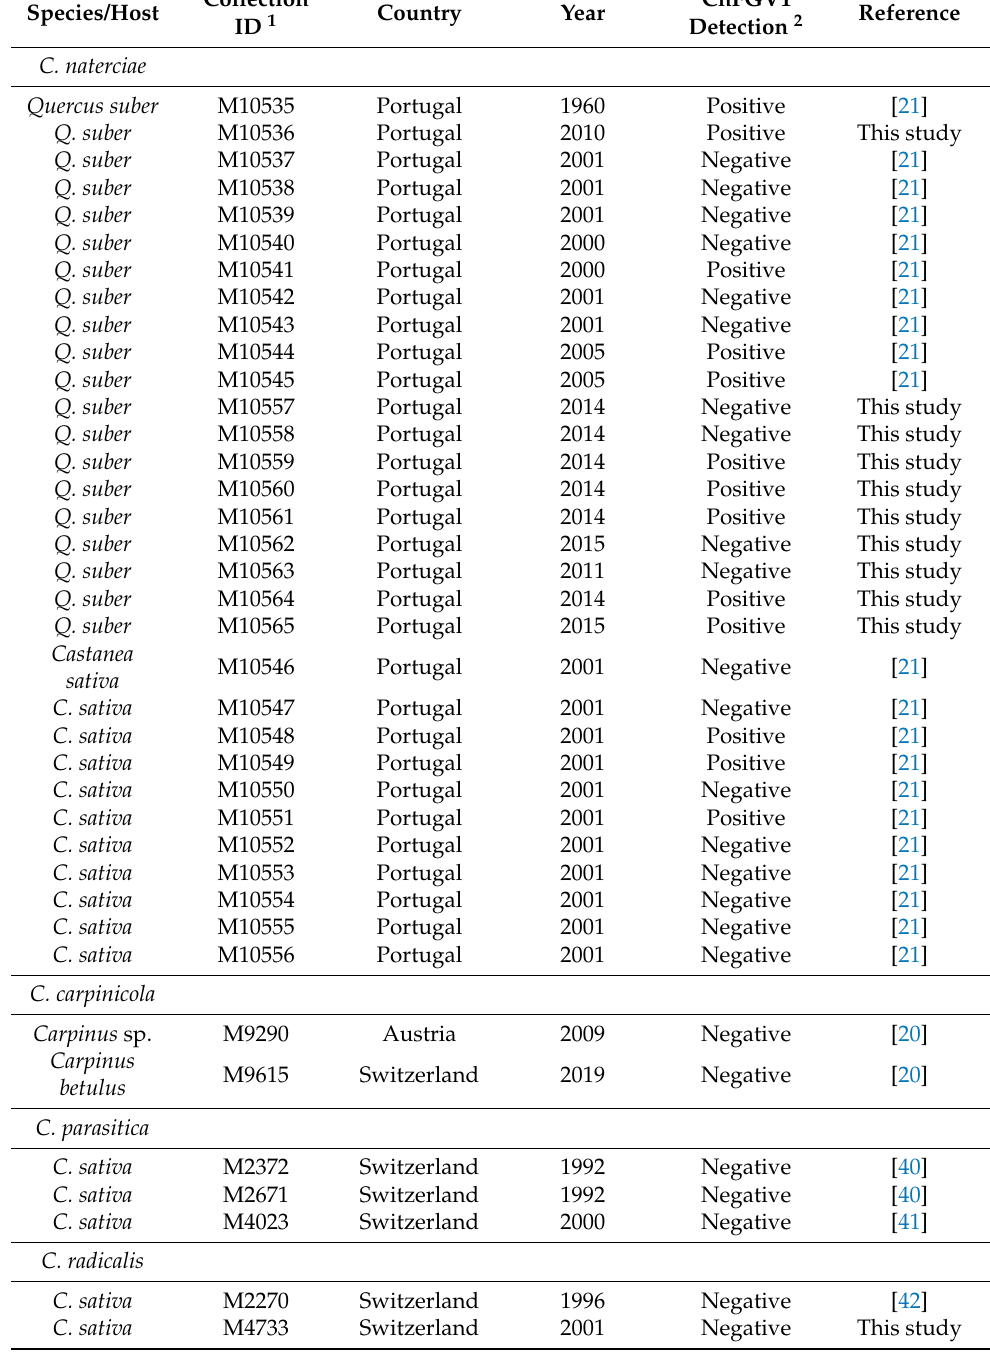
Table 1. Strains of the genus Cryphonectria used in this study.